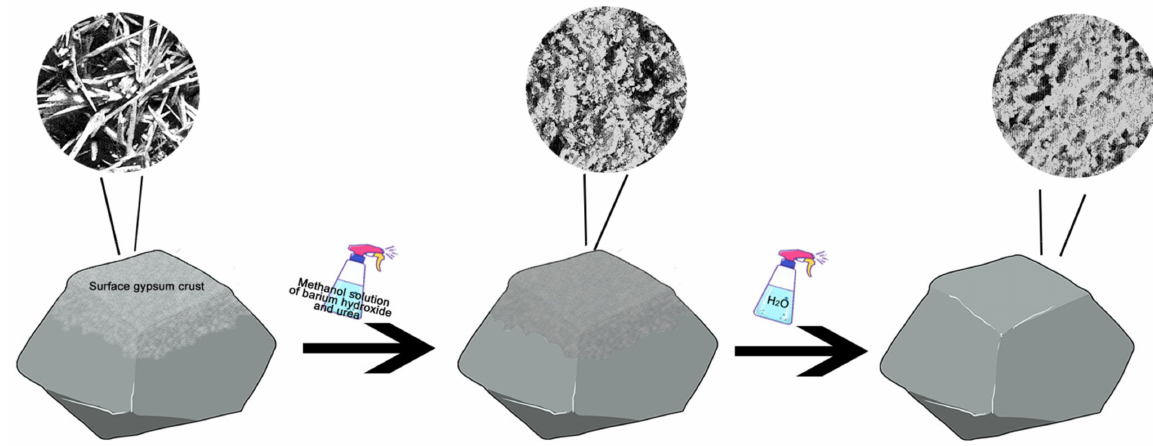
Figure 1. Conservation schematic diagram of surface gypsification stone